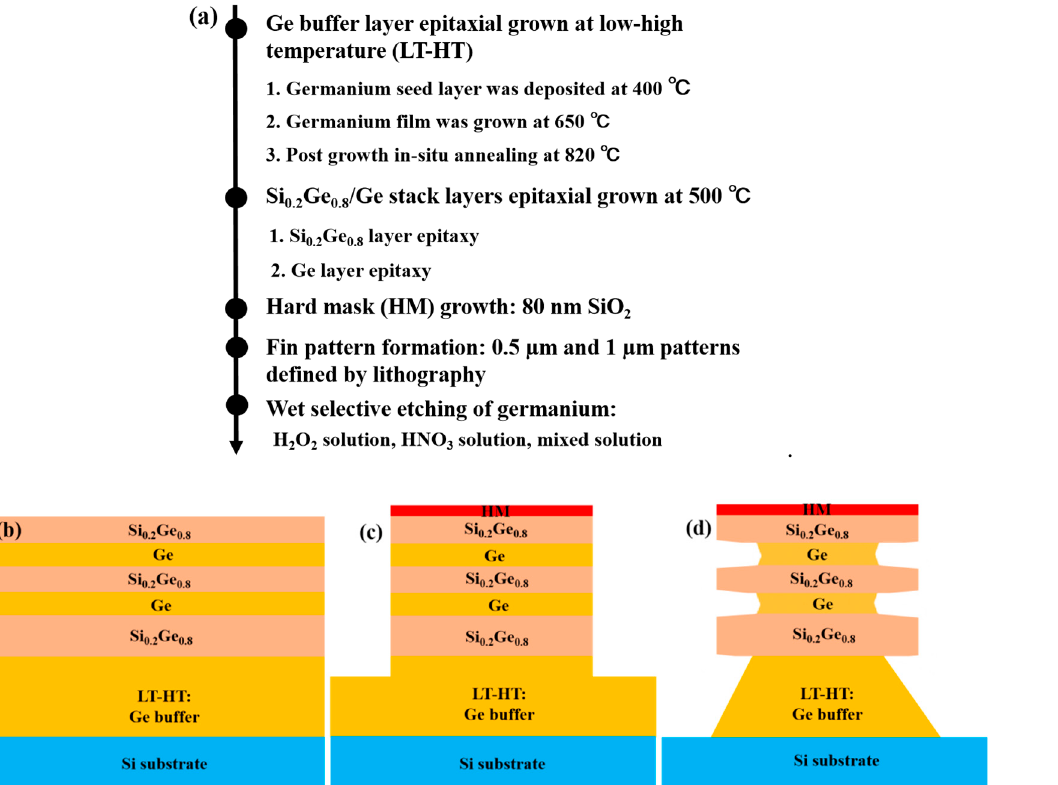
Figure 1. ( a ) Main process flow diagram, ( b ) material structure, ( c ) fin pattern formation with hard mask (HM), ( d ) wet selective etching of Ge in Si 0.2 Ge 0.8 /Ge multilayers.